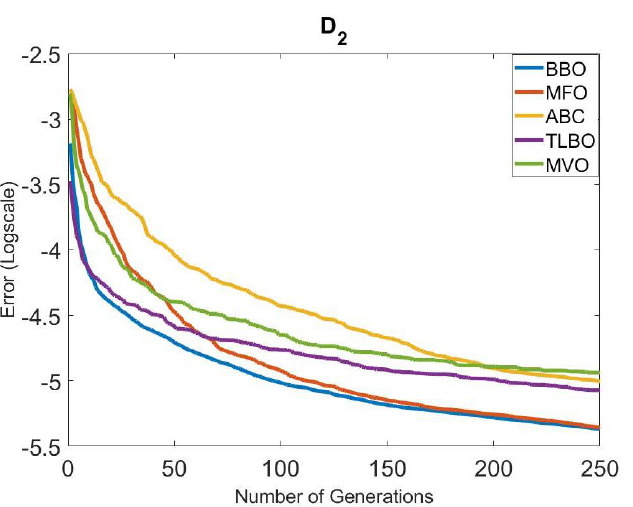
Figure 9. Comparison of the convergence of the metaheuristic algorithms in Group 1 for D 2